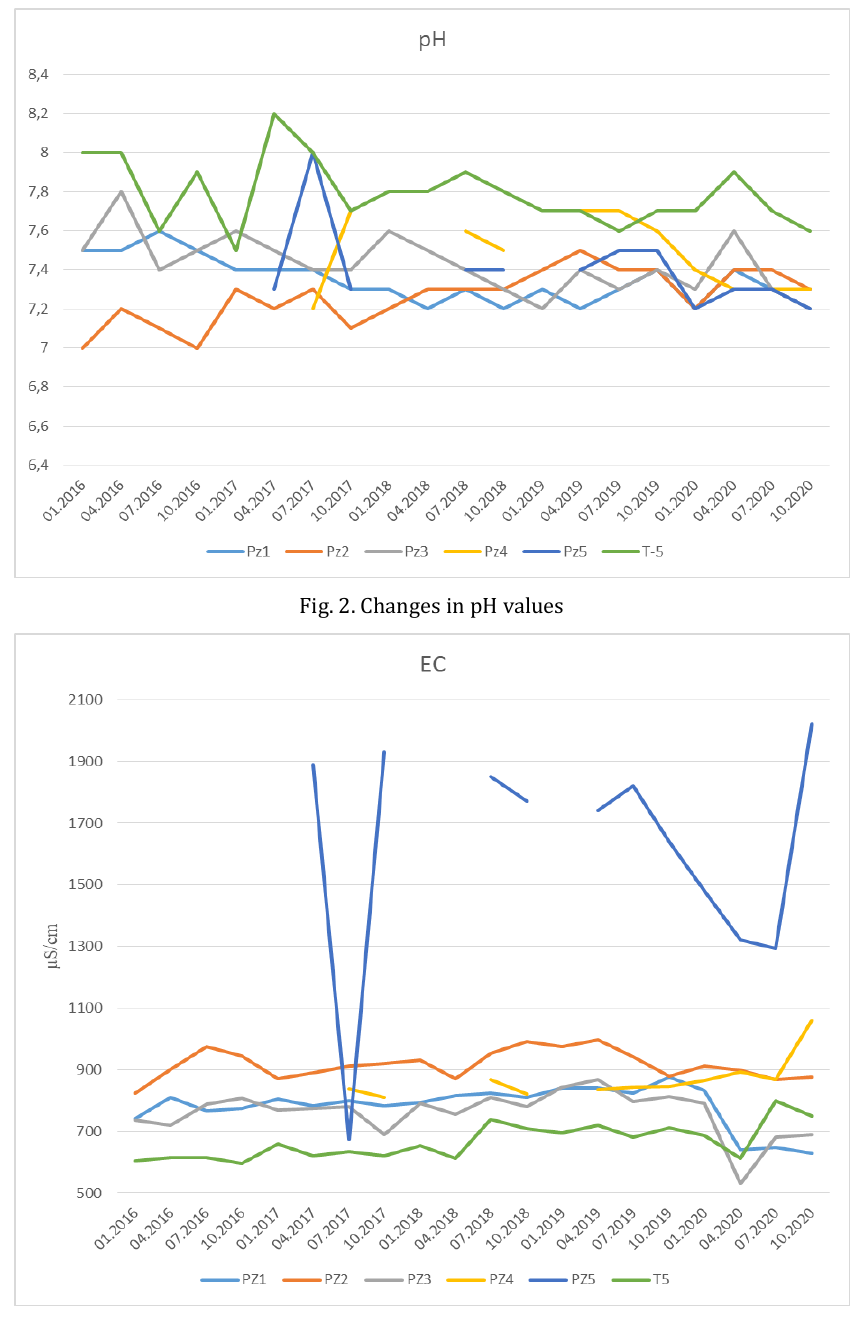
Fig. 2. Changes in pH values